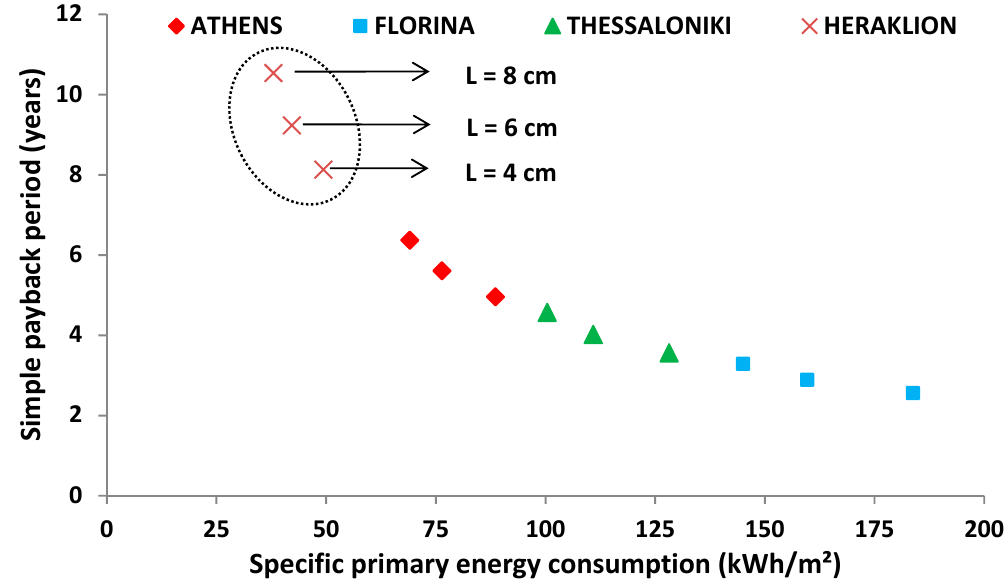
Figure 9. Multi-objective evaluation of the results for insulations cases of 4, 6, and 8 cm.